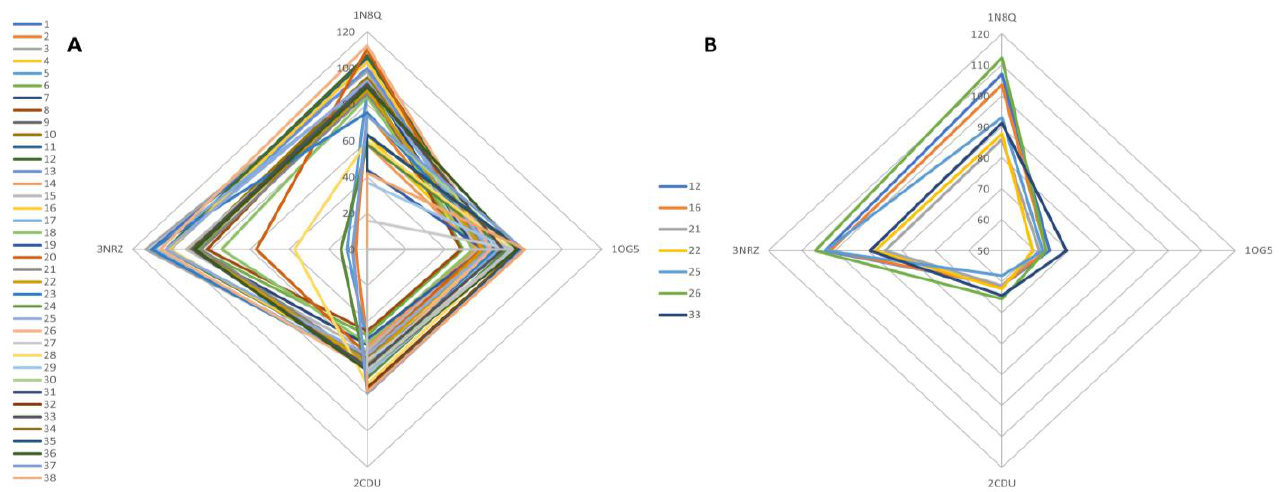
Figure 4. Graphical representation of the docking scores related to antioxidant protein targets, corresponding to 39 TPEO components ( A ) and 7 major TPEO constituents ( B ) (representing over 75% of the essential oil); docking scores calculated as a percentage of the native ligand’s score of each target protein; the results are plotted in the form of a radar chart where docking scores (recalculated as a percentage of the native ligand’s docking score) of each compound, represent a series and the target proteins are in the corner of the graph.